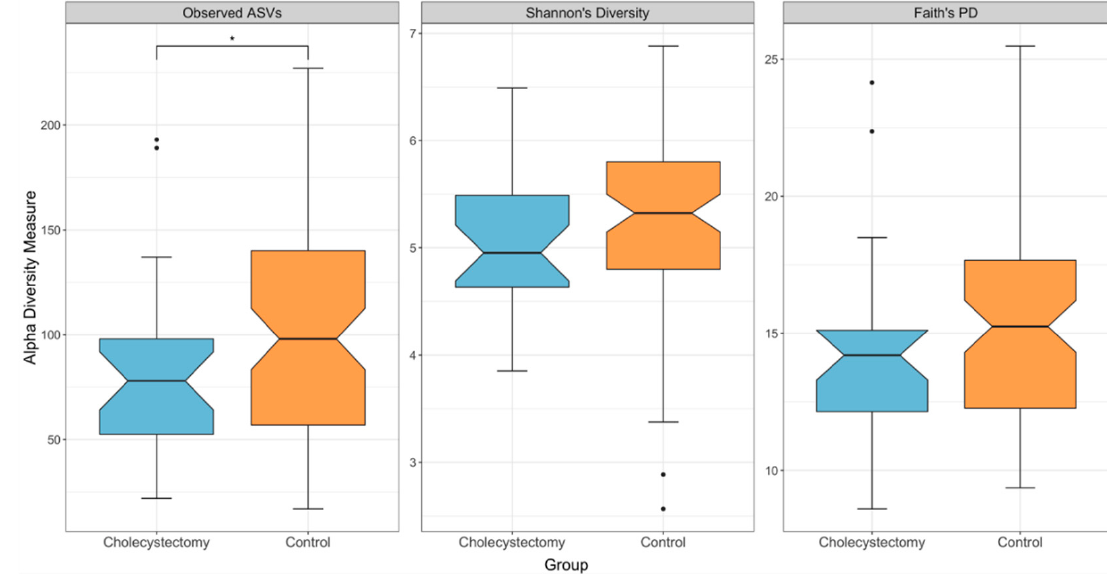
Figure 1. Boxplots of the alpha-diversity indices in the cholecystectomy and control groups. From left to right, observed amplicon sequence variants (ASVs), Shannon’s diversity index, and Faith’s phylogenetic diversity (cholecystectomy group, n = 27; control group, n = 81). * q < 0.05 (Kruskal–Wallis test, Benjamini–Hochberg correction).